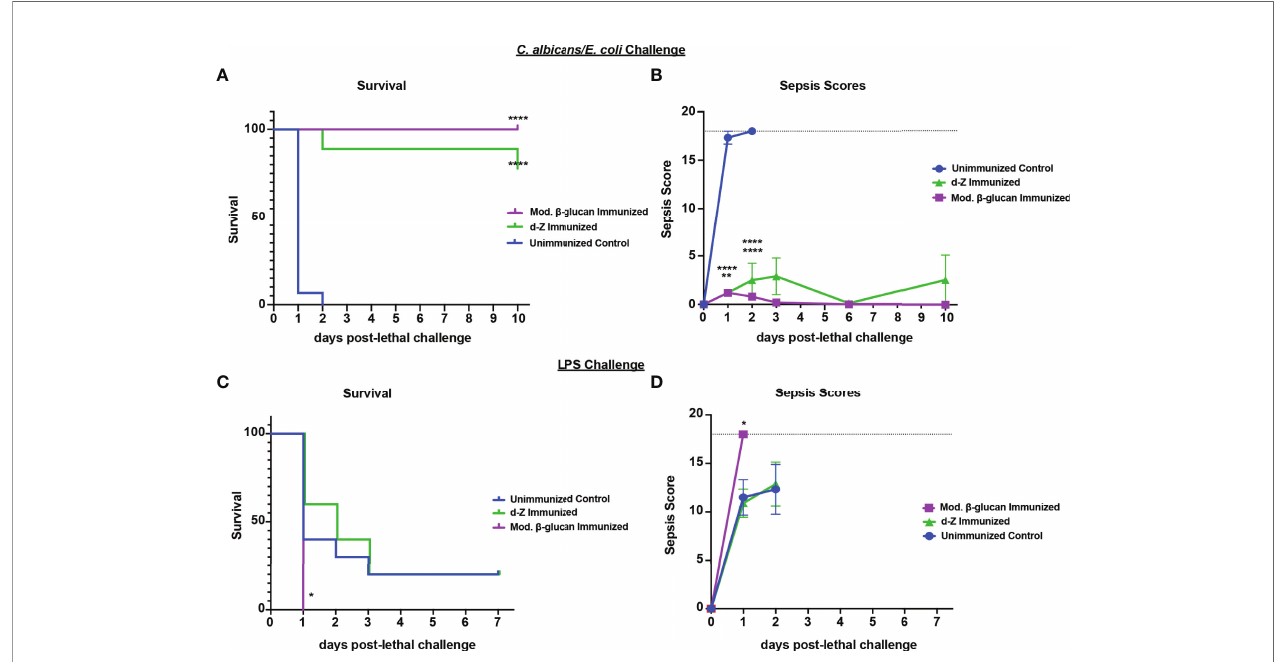
FIGURE 7 | Immunization with b -glucan preparations induces protection against lethal polymicrobial C. albicans/E.coli IAI but not LPS-induced sepsis. Mice (n= 10/ group) were immunized with either modi fi ed b -glucan or d-zymosan prior to lethal challenge as described in Figure 5 . Mice were then challenged by i.p. injection with C. albicans (1.75x10 7 CFUs) and E. coli (4.5x10 6 CFUs) (A, B) or LPS (10 mg/kg) (C, D) and monitored for survival (A, C) and morbidity/sepsis scoring (B, D) for 7-10 days post-lethal challenge. Naïve (unvaccinated) mice served as the negative control. Graphs are representative of 2-4 separate experiments and (A&B) a cumulative of 2 separate experiments. *, P<0.05; **, P<0.01; ***, P<0.001; ****, P<0.0001 [for values signi fi cantly different from those of the control, by log rank Mantel-Cox test (survival) and ANOVA followed by post hoc Student ’ s t-test (sepsis